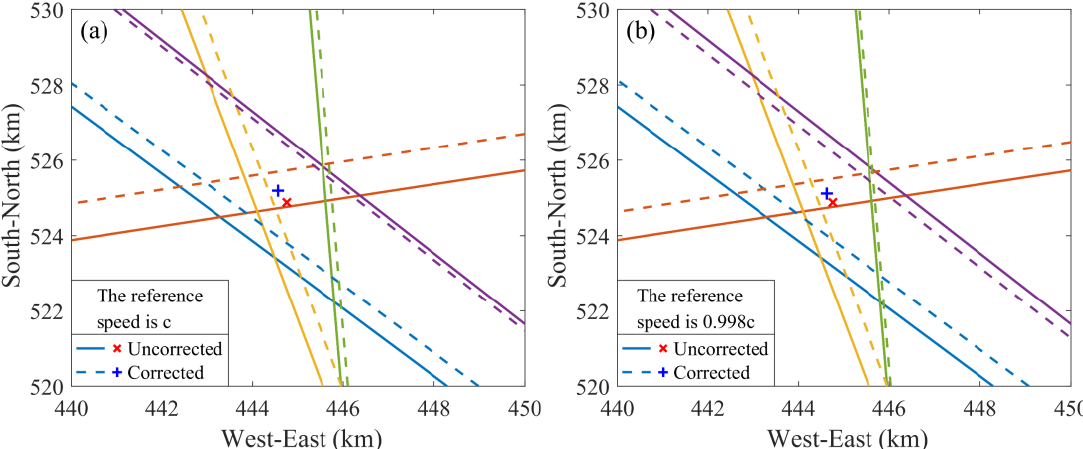
Figure 5. The horizontal projection of the hyperbolic map as well as the optimum locations for corrected (dashed lines/ “+” in blue) and uncorrected (solid line / “ × ” in red) for the propagation of the signals shown in Figure 1. Five hyperbolas of different colors are shown corresponding to the following sensor pairs: CD – CF, CD – JQ, CD – NJ, CD – TY and CD – WH. ( a ) Compensating the peak time delay with a reference speed of 𝑐 . ( b ) Compensating the peak time delay with a reference speed of 0.998 𝑐 .